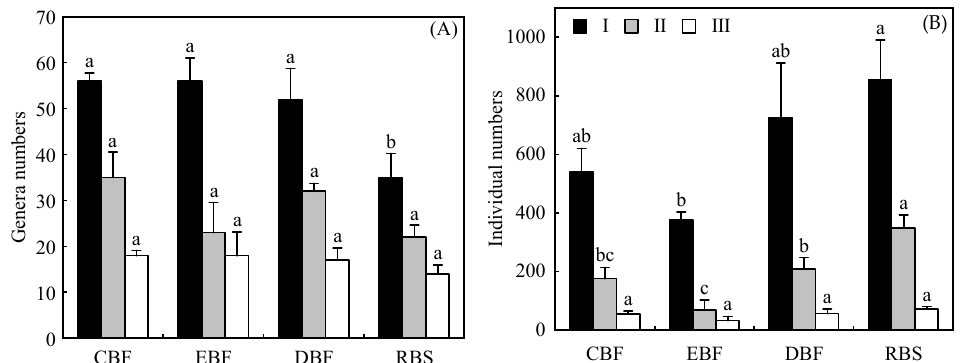
Figure 2. Horizontal and vertical varieties on genera numbers ( A ) and individual numbers ( B ) of soil mites in the study area. Ⅰ : Humic layer; Ⅱ : Soil upper layer (0–50 mm); Ⅲ : Soil lower layer (50–100 mm). The same below. Note: Different lowercase letters indicate significant differences in the number of soil mite genera (number of individuals) between different vegetation types under the same soil layer ( p < 0.05).